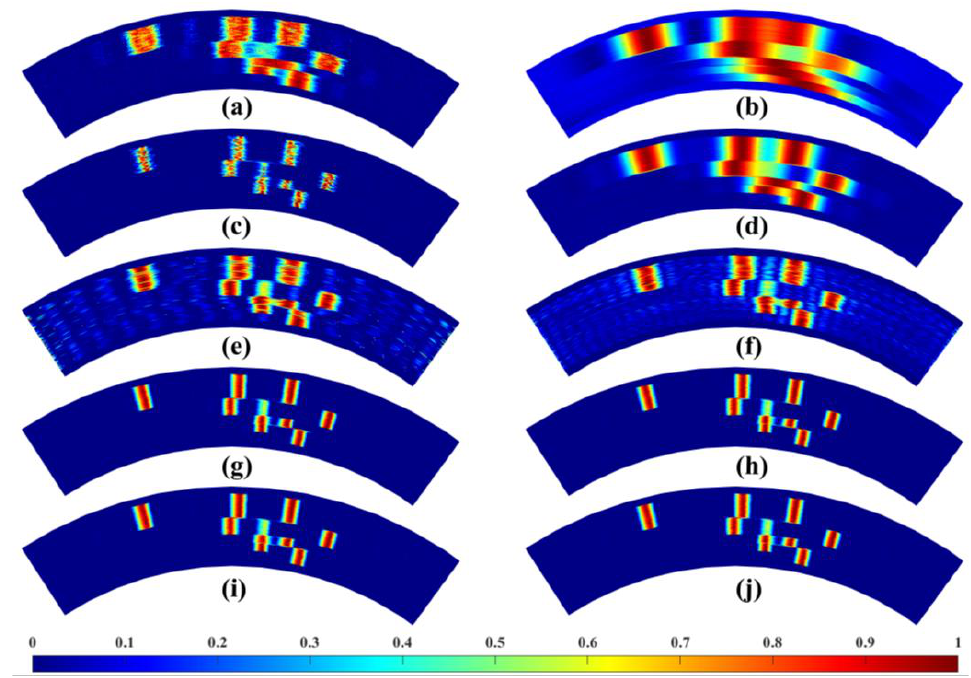
Figure 13. Restored results of simulated surface targets with convolution and noise degradation when the SNR of noise is 25 dB. ( a ) Blind deconvolution. ( b ) Regularized Filtering. ( c ) Richardson–Lucy. ( d ) Wiener Filtering. ( e ) TSVD. ( f ) SDBSM. ( g ) TV. ( h ) TV BC. ( i ) TVS. ( j ) TVSBC.